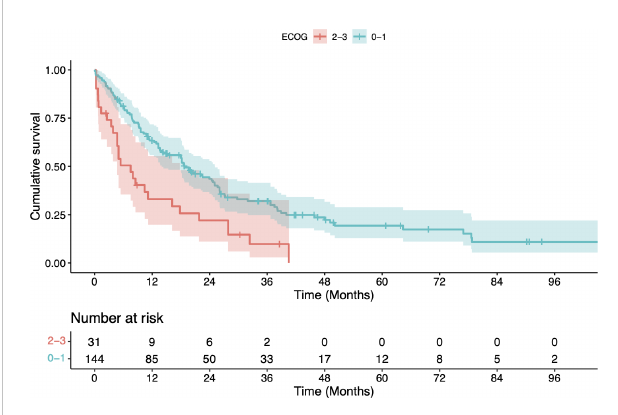
FIGURE 1 Kaplan-Meier estimate of overall survival (OS) after radiotherapy strati fi ed by Eastern Cooperative Oncology Group (ECOG) Performance Score 0 - 1 vs. 2 - 3. OS was signi fi cantly better for patients with an ECOG of ≤ 1 (p = 0.001, log-rank